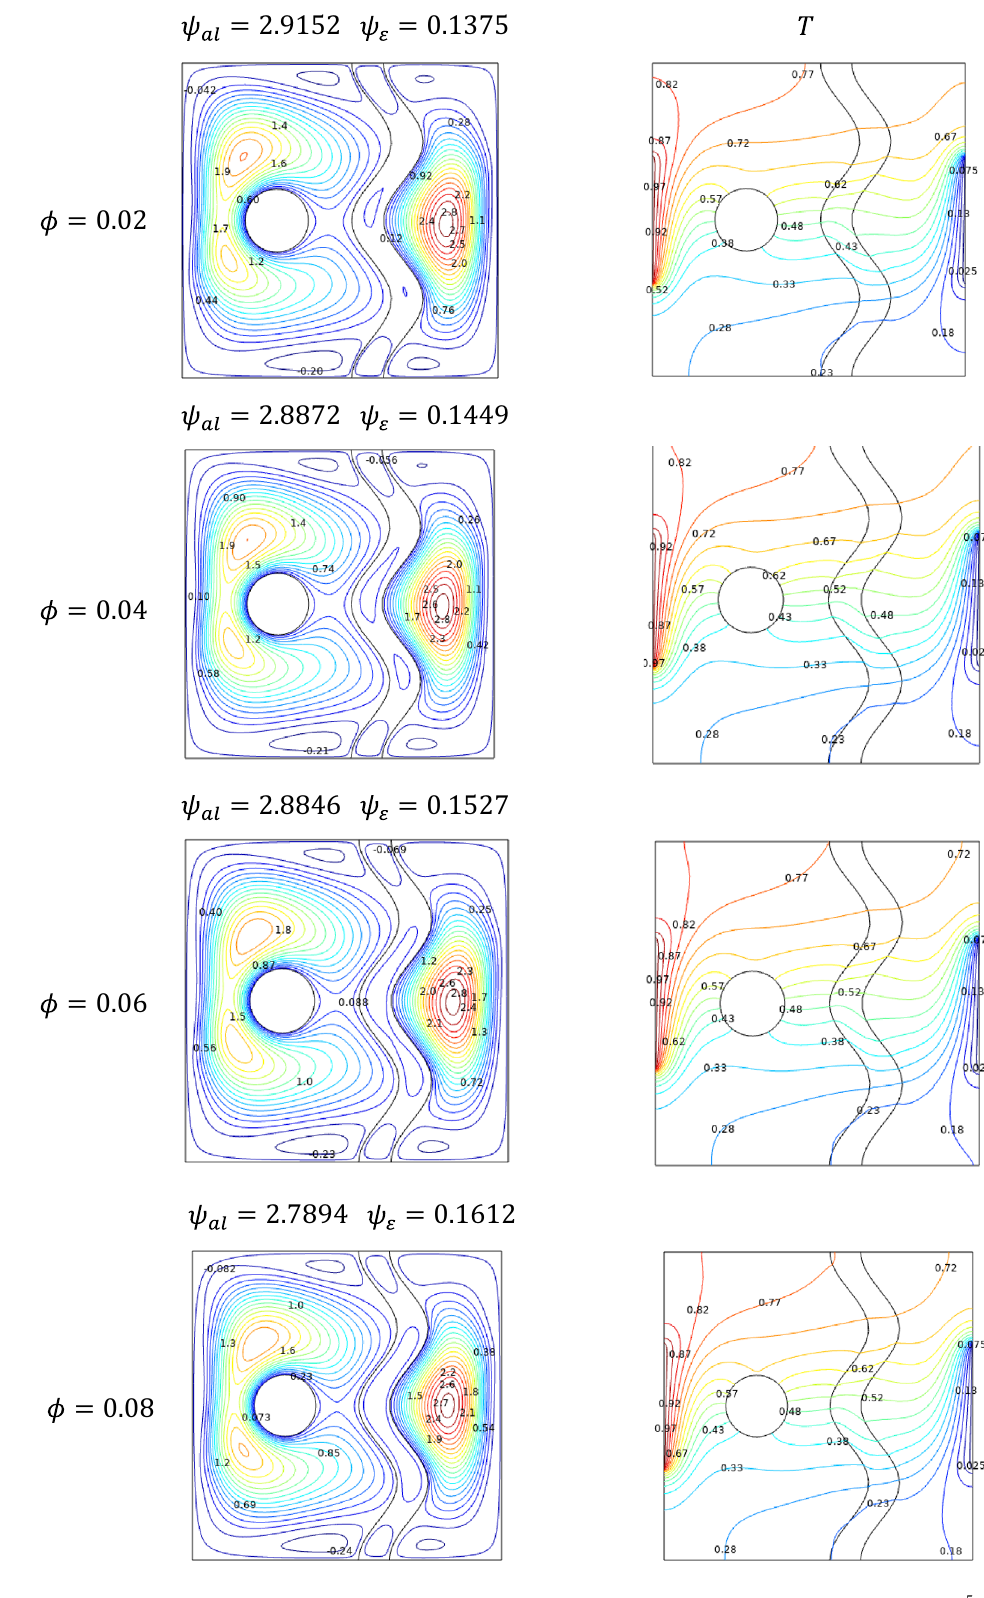
Figure 12. Variations of the streamlines (left), (right) with nanoparticles concentrations ( φ ) at, Ra 0 , N 0.2 , Da 0.01 and ω 2 , ε Ha = = = =